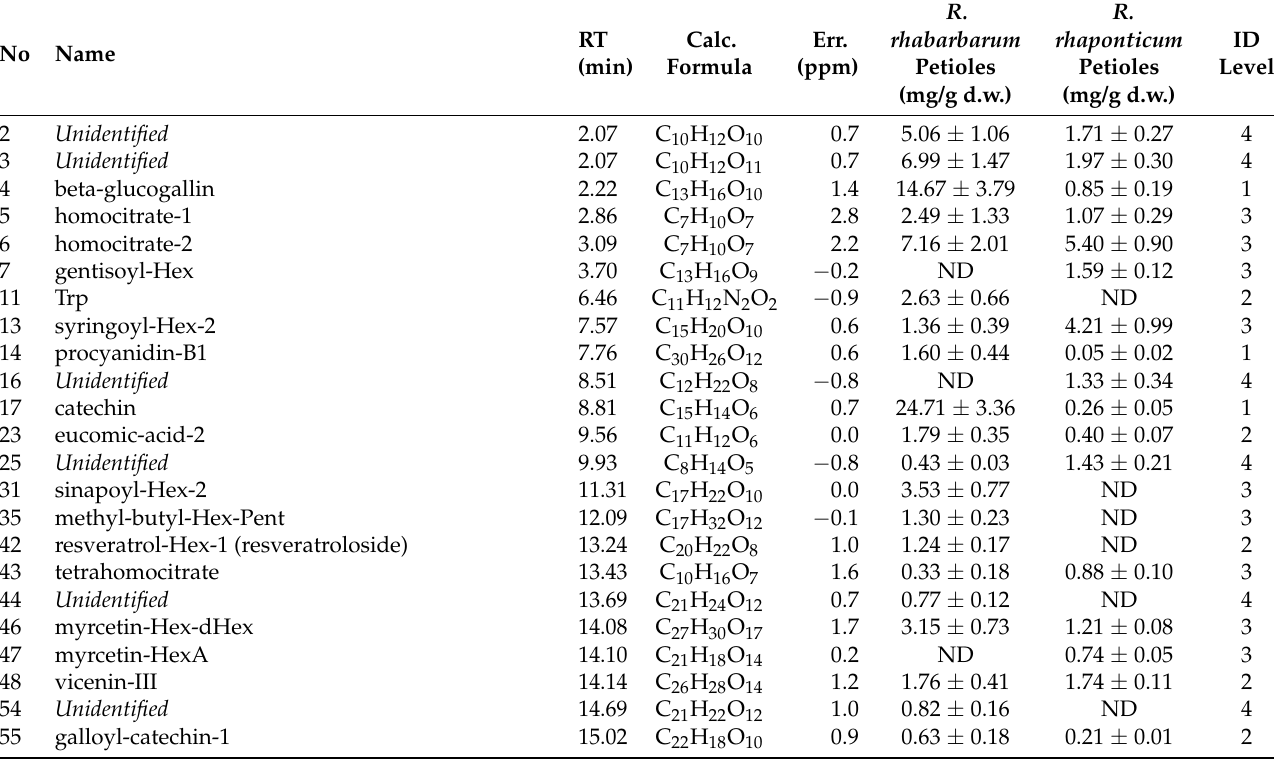
Table 2. Main metabolites detected in the butanol fractions of the petioles and roots of R. rhabarbarum and R. rhaponticum . A complete dataset is available in Tables S2 and